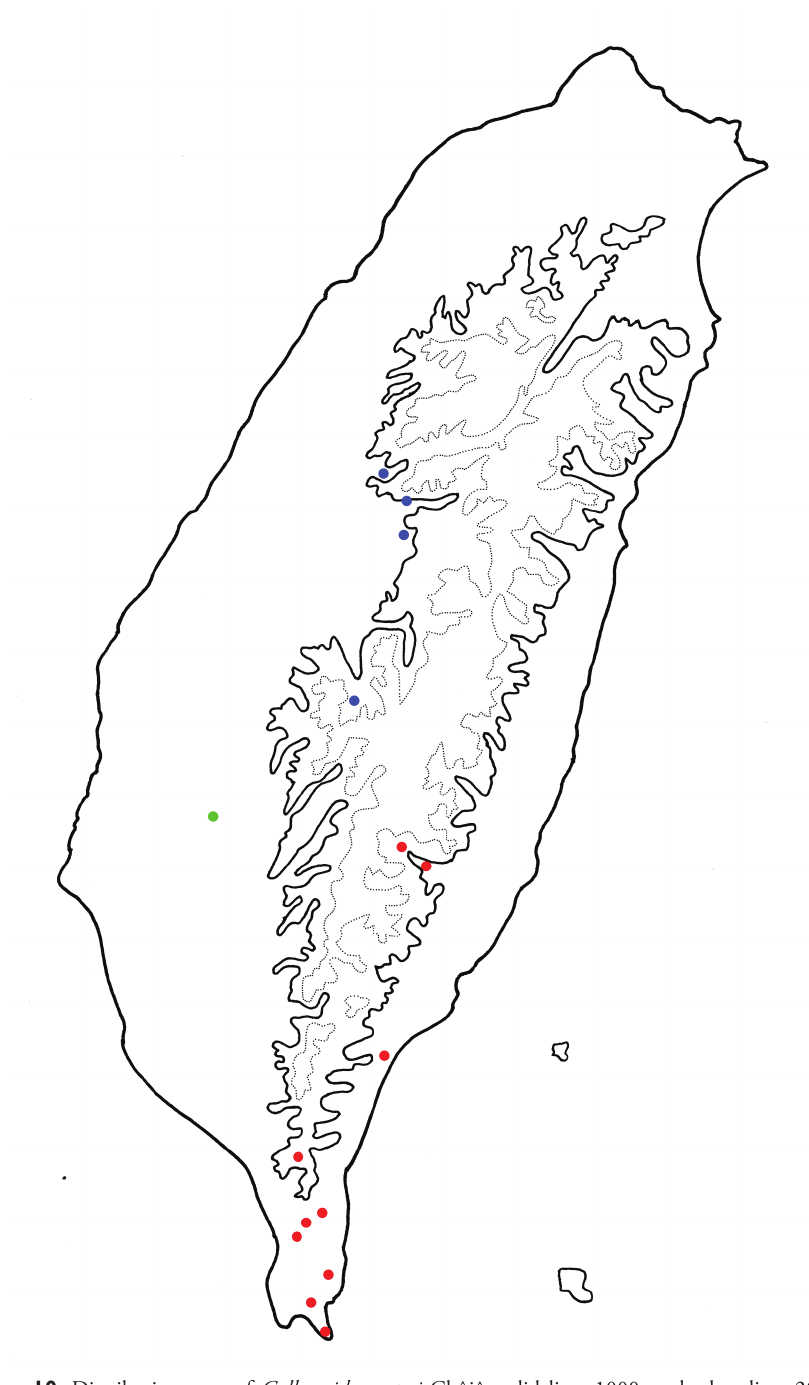
Figure 10. Distribution map of Gallerucida sauteri Chûjô, solid line: 1000 m, broken line: 2000m. Red dots Typical form Blue dots Color variation as G. quadraticollis Green dot Intermediate